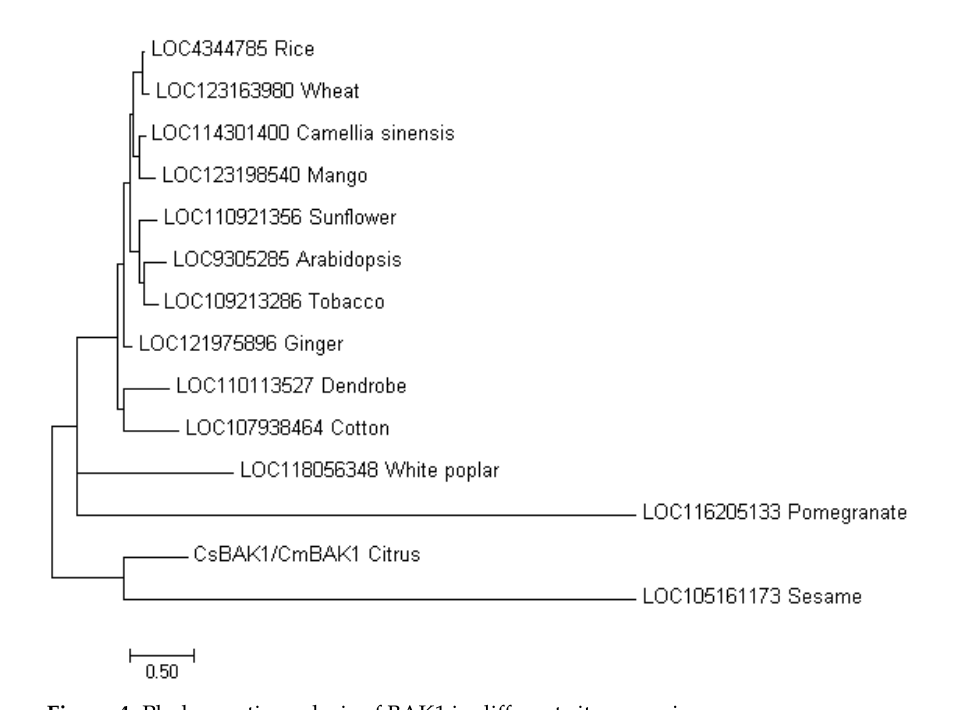
Figure 3. Secondary structure of BAK1. LRR: leucine-rich repeats motif; S_TKc: Tyrosine kinase,